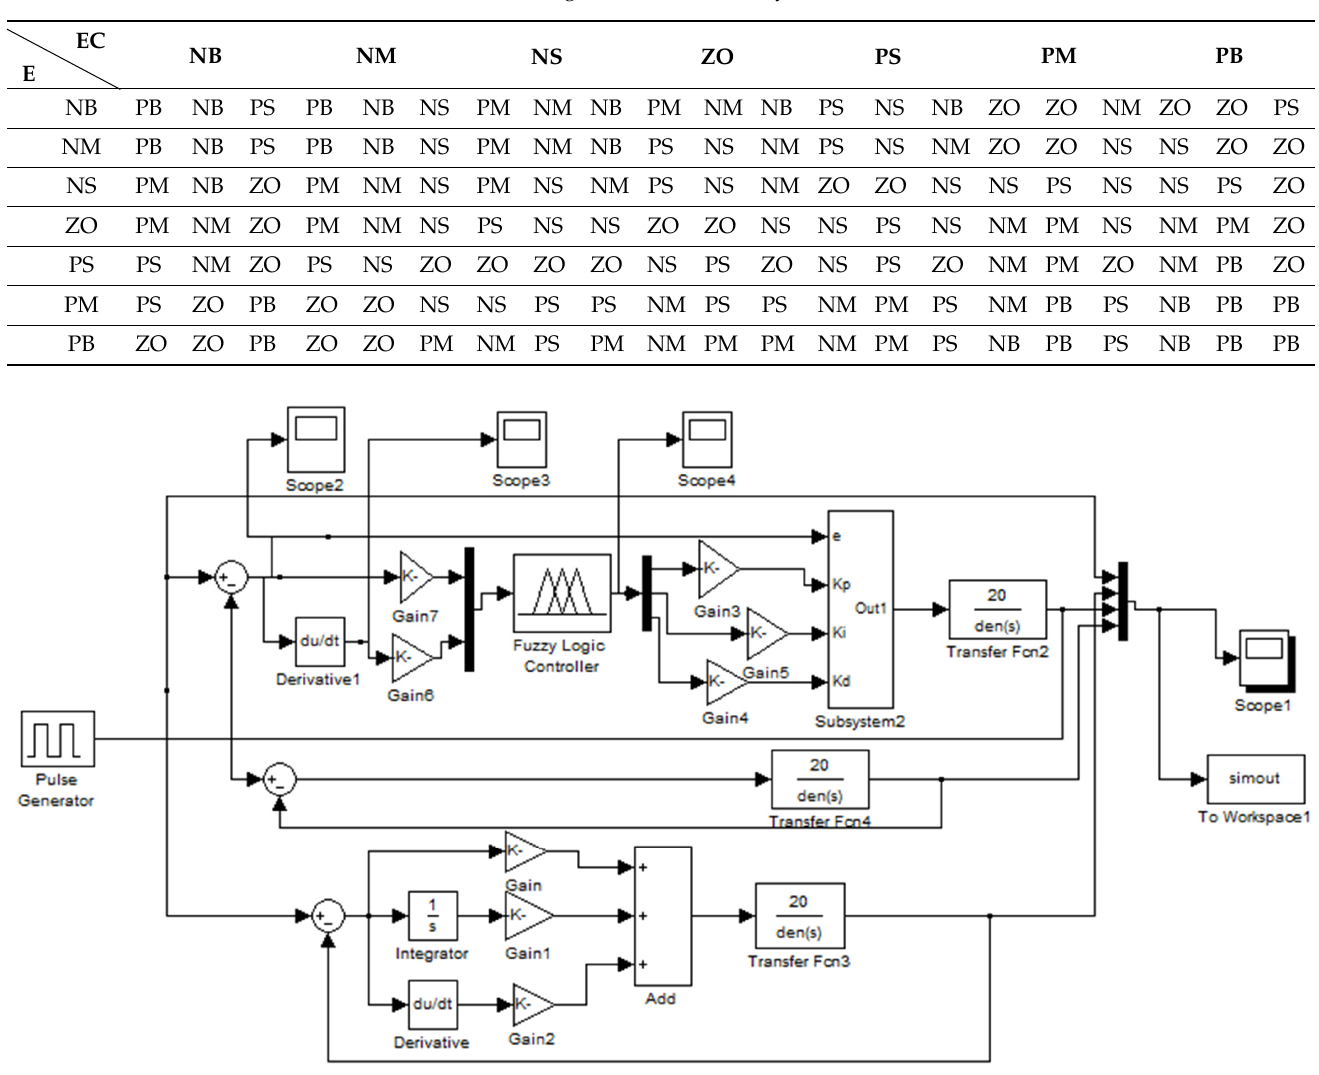
Figure 6. Structural diagram of Fuzzy-PID controller. Three different simulation works were carried out using MATLAB. Through using a square wave as an input signal, three different output curves were indicated in Figure 8, we can see that the Fuzzy-PID control method has the best tracking ability, the smallest overshoot and the shortest adjustment